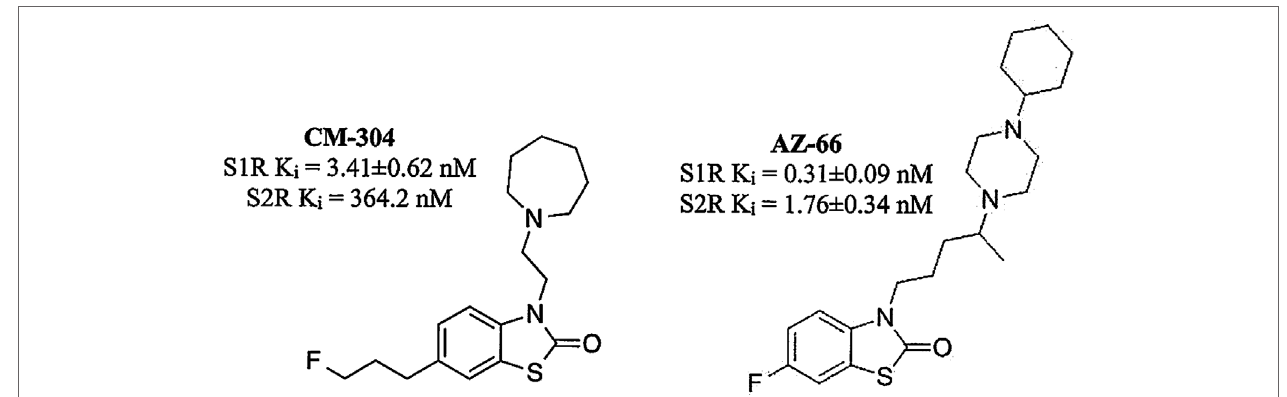
FIGURE 1 | Structures of CM-304 and AZ-66